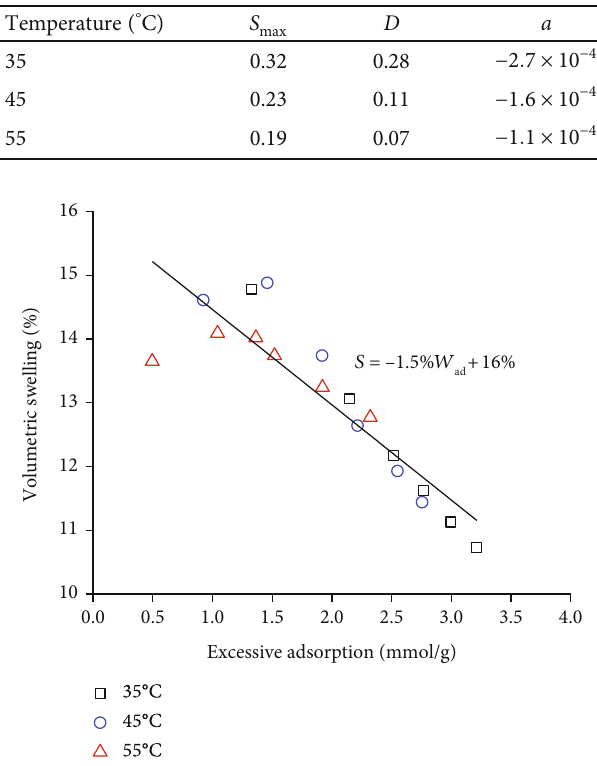
Figure 8: Volumetric swelling with excessive adsorption.